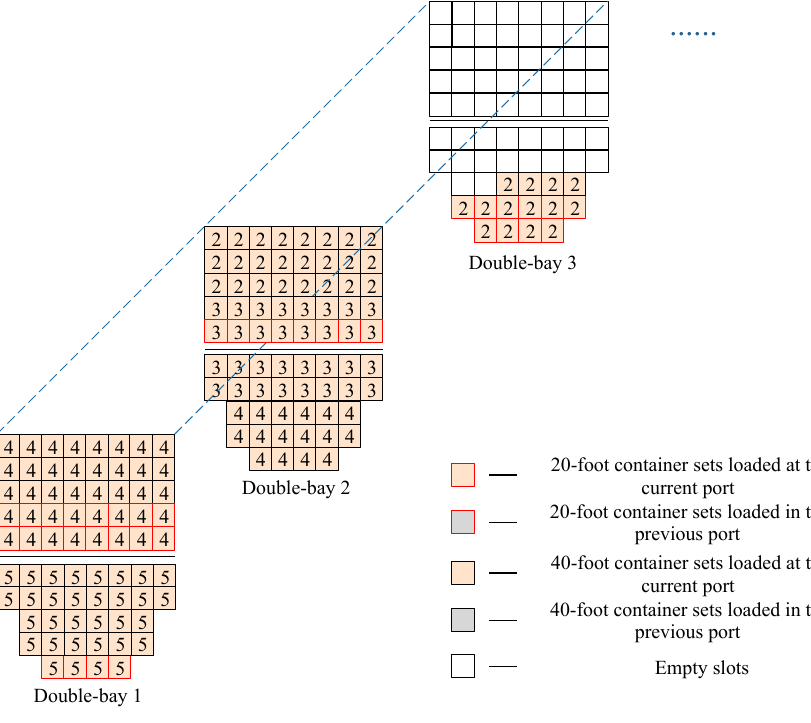
Figure 5. Stowage results in port 1 with rule R1.